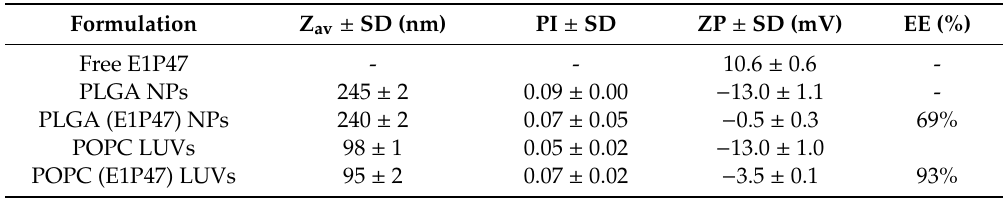
Table 1. Average size (Z av ), PI, ZP and EE values of PLGA (E1P47) nanoparticles (NPs) and